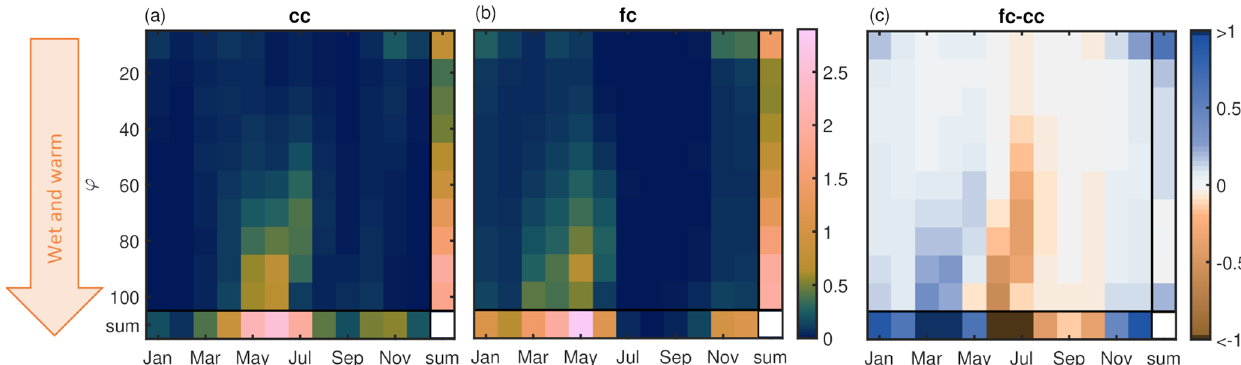
Figure 9. Histogram showing the number of ROS events for (a) current climate (cc) and (b) future climate (fc; RCP 8.5 at the end of the century) and (c) the difference therein (fc − cc), split in different values of ϕ , i.e. the ratio of pixels obeying criterion 1 over pixels obeying criterion 2 per event. The colour bar indicates the number of ROS events per year averaged over 1500 years for the current climate and 10 × 1500 years for future-climate conditions. For the month with the lowest number of ROS events in the current climate, in February, there are approximately 100 ROS events available in the data